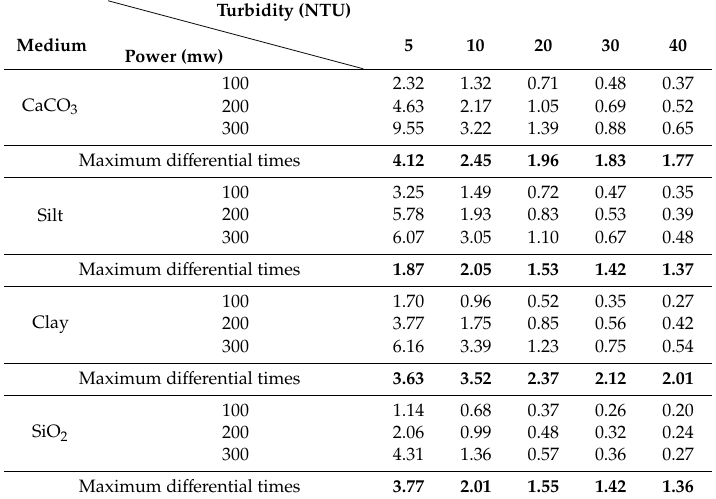
Table 3. Maximum detection range and laser power selection recommendation